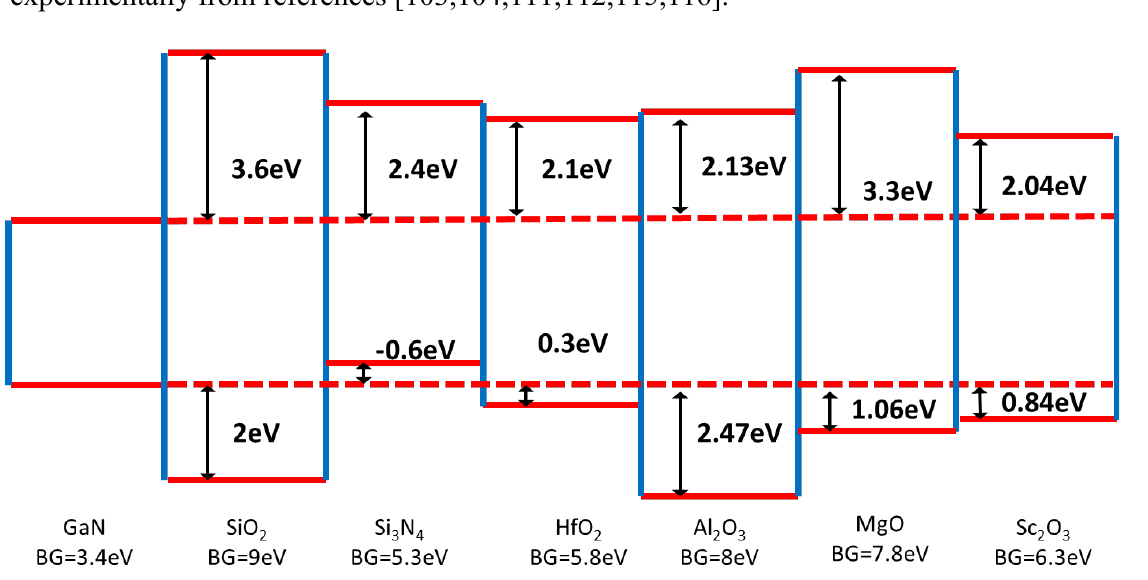
Figure 11. Conduction and valence band offsets for varying dielectrics on GaN determined experimentally from references